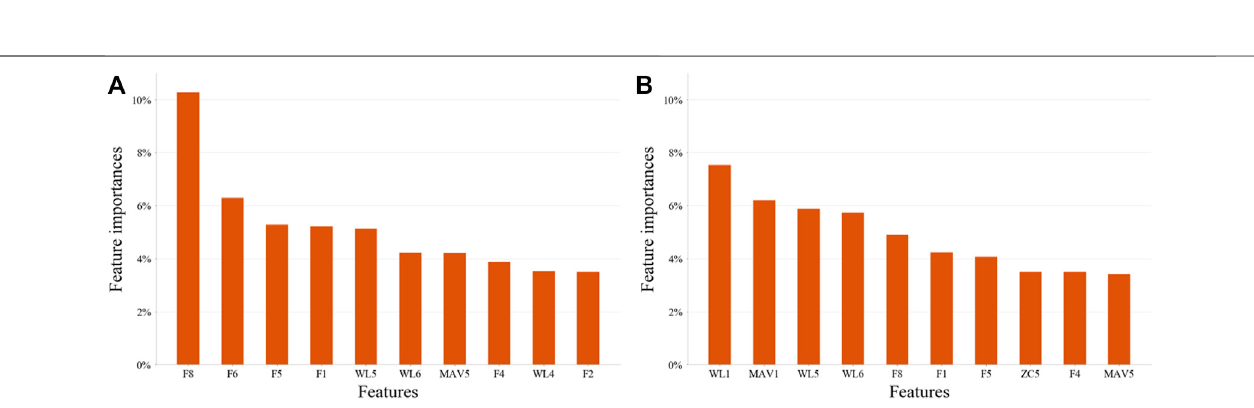
FIGURE 8 | The most important 10 features on two pairs hand gestures recognition by using EMG-and-FMG-model. (A) , Ten features contributed most to the classi fi cation of hand gesture SG and CG. (B) , Ten features contributed most to the classi fi cation of hand gesture MF and HG.